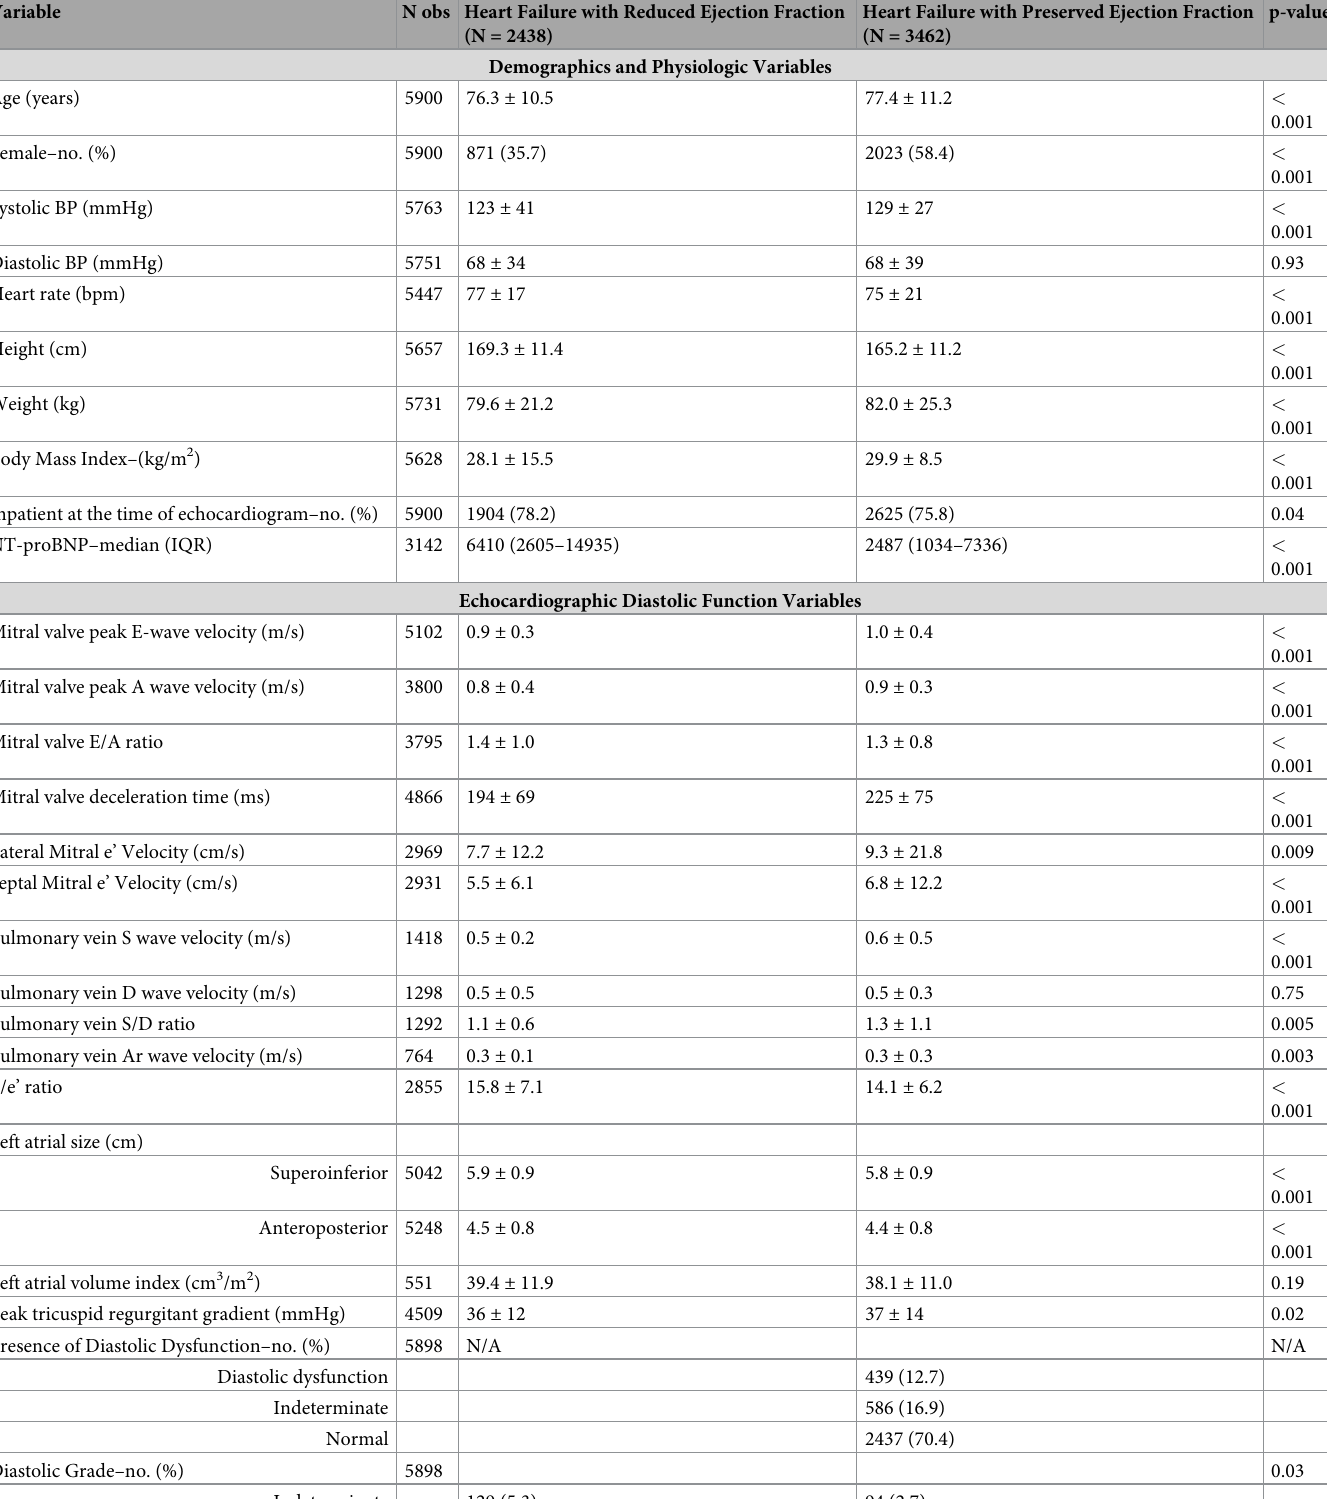
Table 1. Baseline characteristics of included individuals by left ventricular function category a